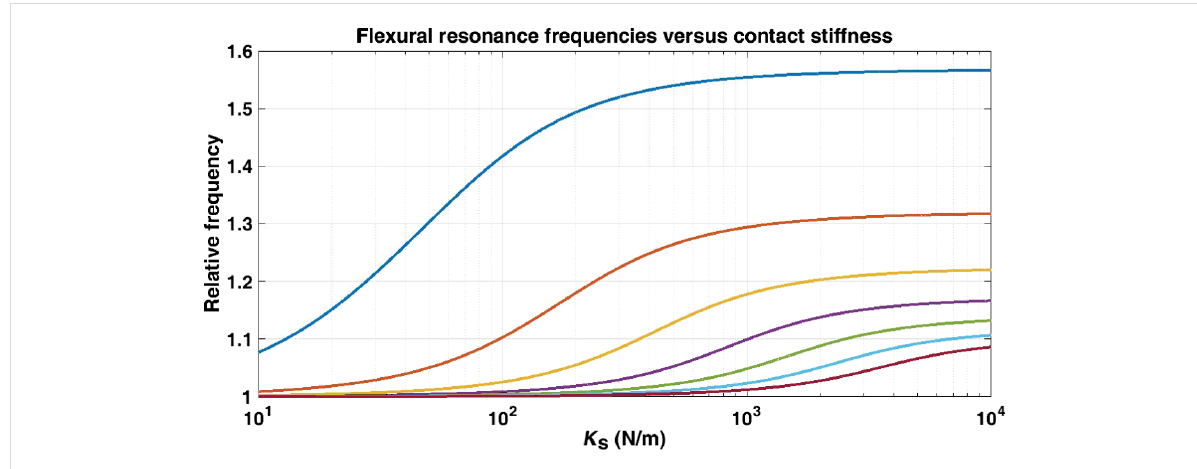
Figure 5: Flexural resonance frequencies as a function of the contact stiffness for a cantilever with the following geometrical parameters: L = 460 μ m, a = 58 μ m, b = 1.8 μ m.